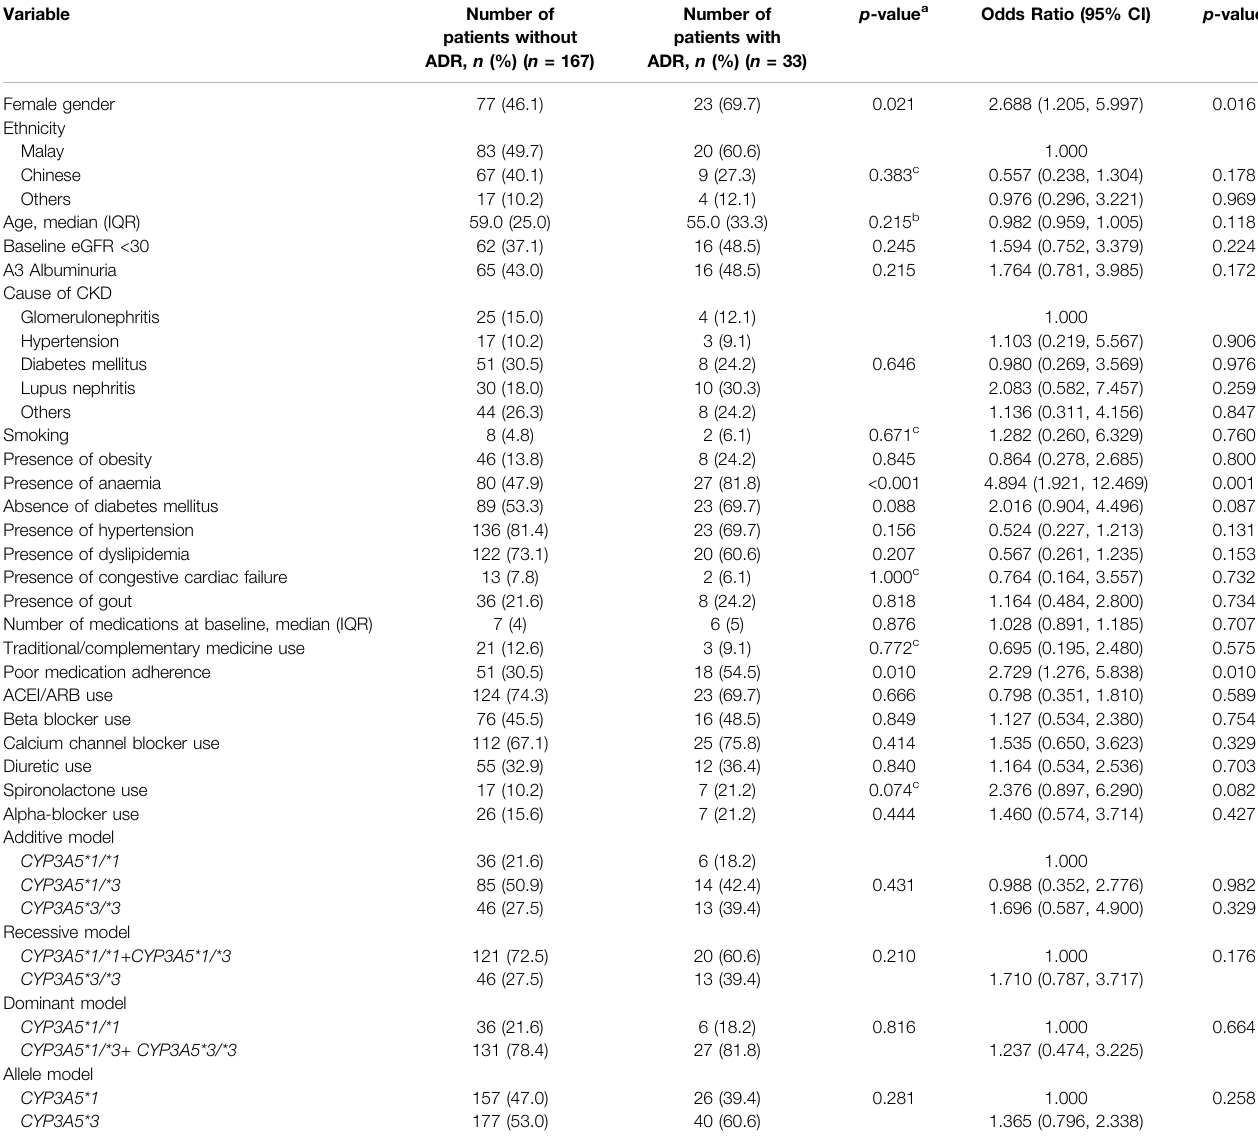
TABLE 1 | Demographic characteristics and factors associated with antihypertensive-related ADR (simple logistic regression). Variable Number of